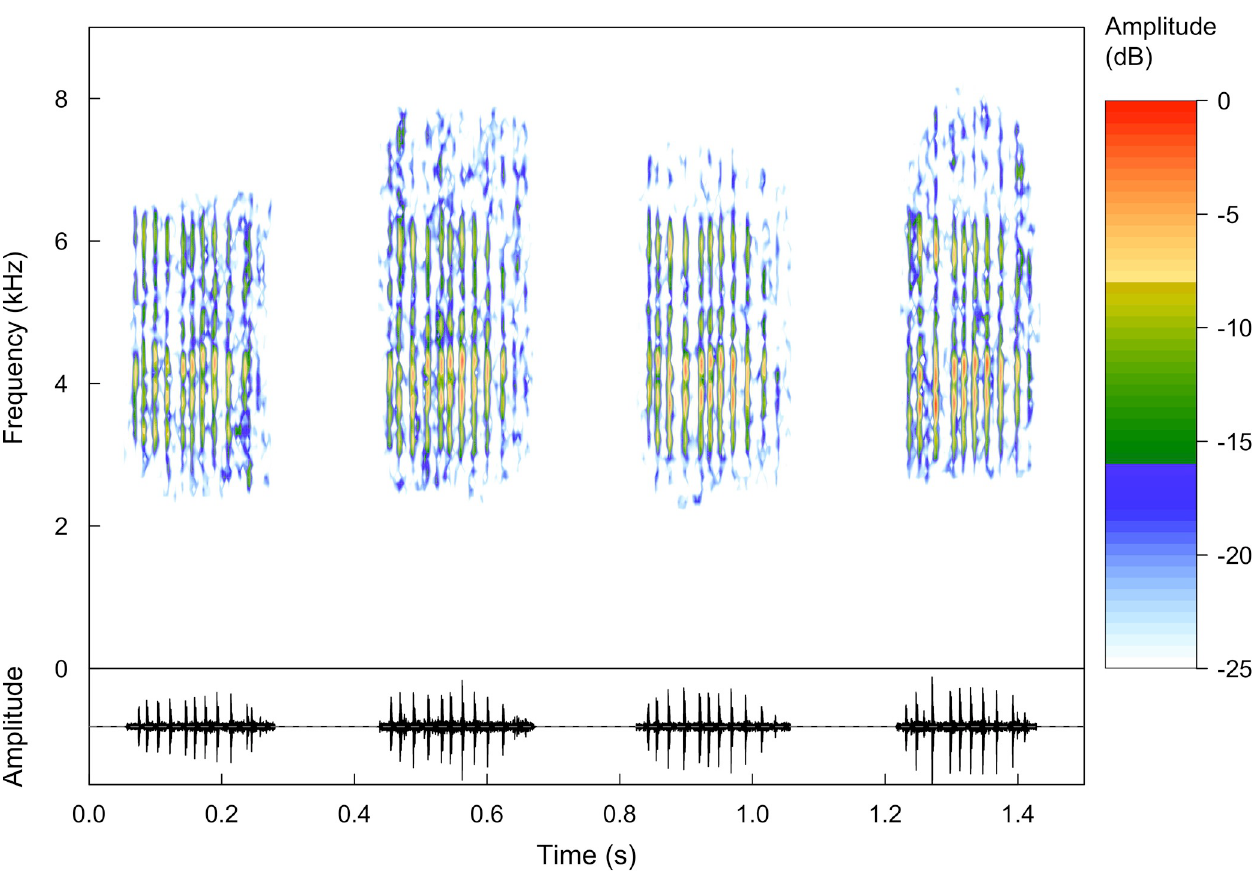
Fig 5. Advertisement call of the holotype of Brachycephalus rotenbergae sp. nov. (HCLP-A 260). Recorded on 5 September 2019 at 08:30 h (FNJV 44409). Spectrogram (above) and oscillogram (bellow).